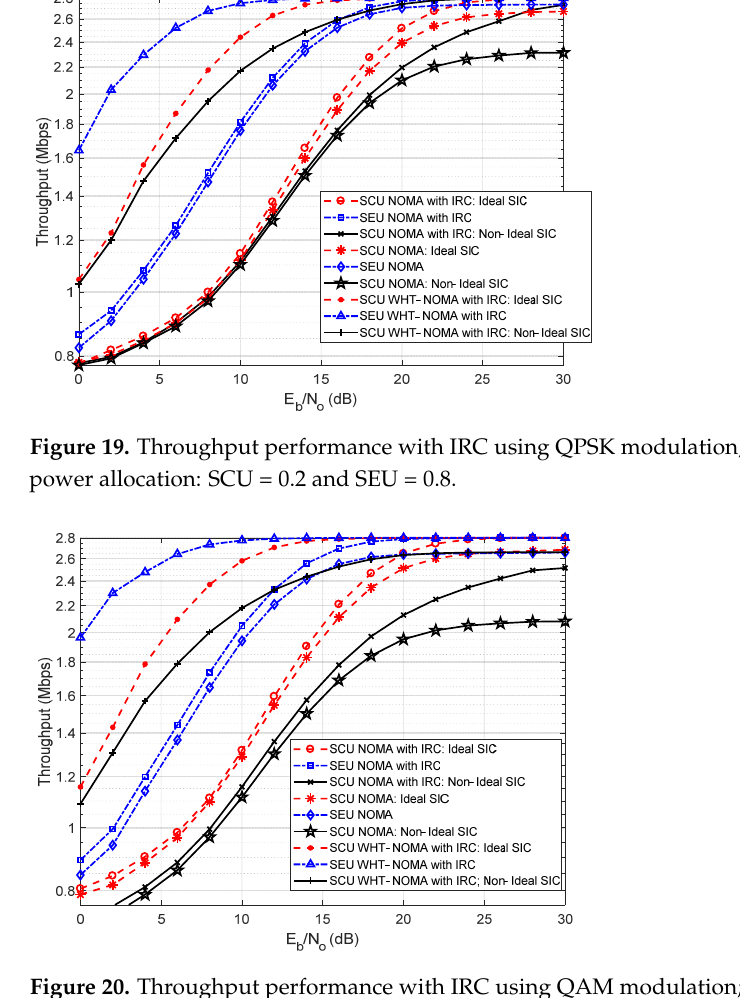
Figure 18. Throughput performance with IRC using BPSK modulation; NOMA vs. WHT–NOMA, power allocation: SCU = 0.2 and SEU = 0.8.